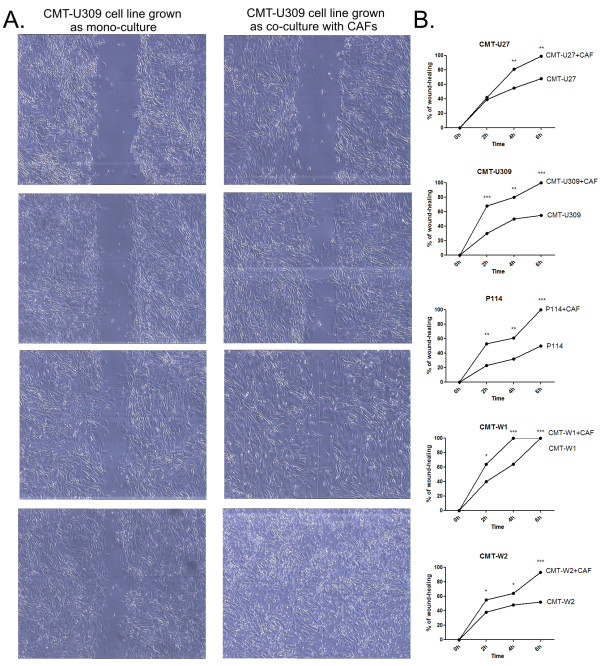
Wound healing assay of canine mammary cancer cells grown in control conditions and as a co-culture with CAFs. A Representative pictures of migration (wound closing) of CMT-U309 cell line grown as a mono-culture and co-culture with CAFs at 0, 2, 4 and 6 hrs after the scratch was made. B The graphs of % of wound closure after the 2, 4 and 6 hrs of migration. The pictures were taken using phase-contrast microscopy (Olympus) at the magnification of 100×. The statistical analysis was performed using Prism version 5.00 software (GraphPad Software, USA). The one-way ANOVA was applied to analyze the results. p < 0.05 was regarded as significant and marked as *, whereas p < 0.01 and p < 0.001 were regarded as highly significant and marked as ** and ***, respectively.